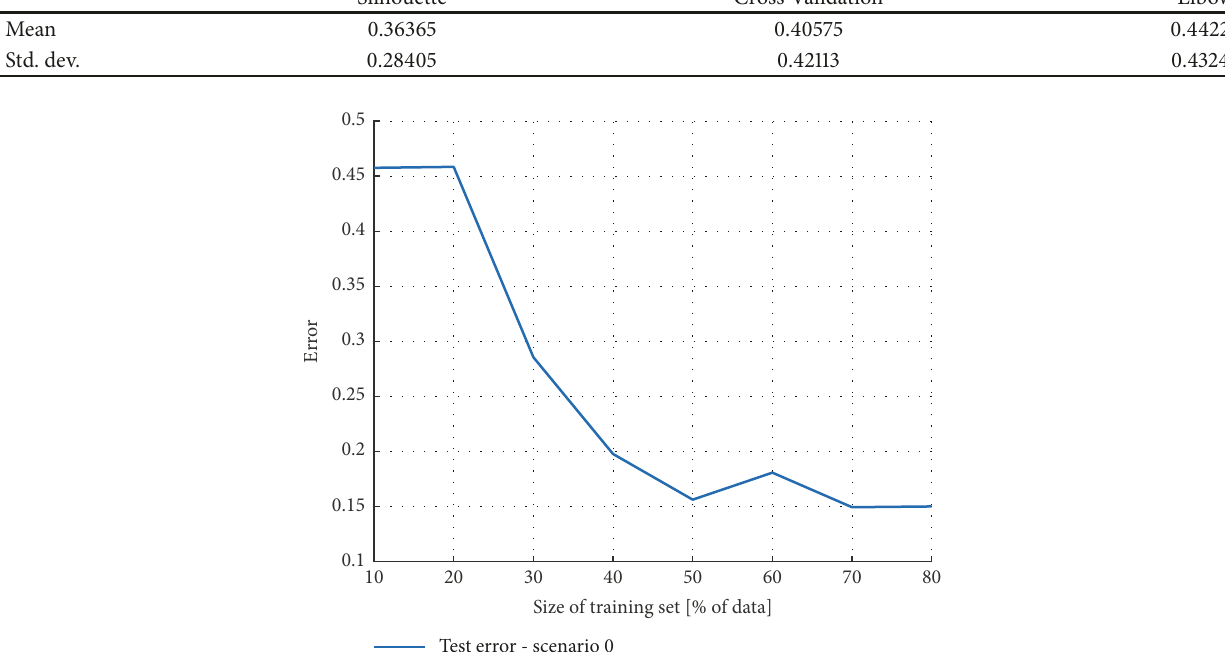
Figure 10: Predicted and actual mean collision probability for the base